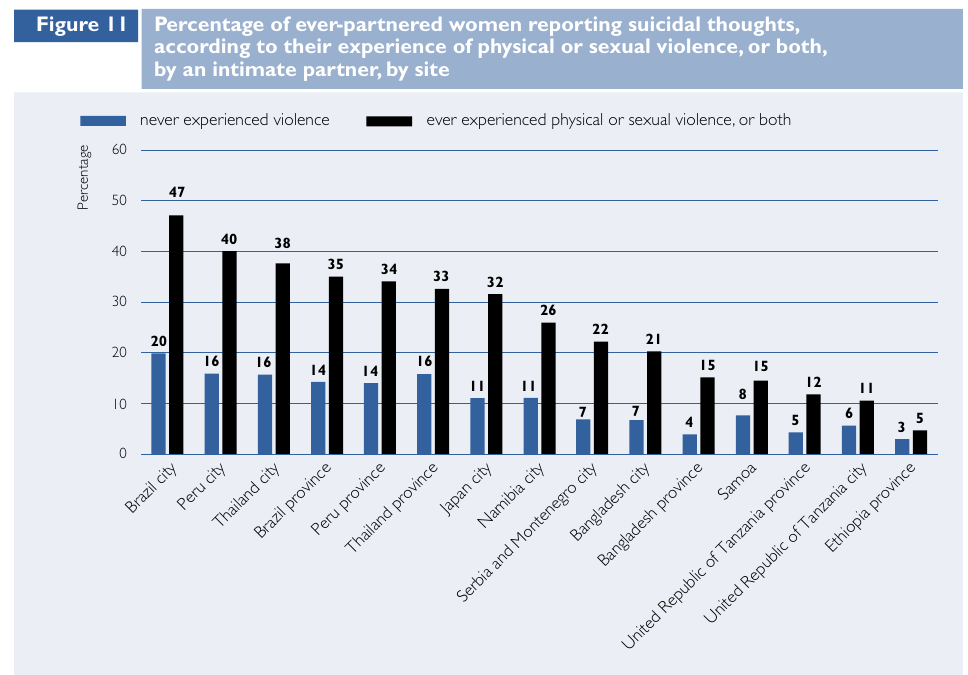
Figure 11 Percentage of ever-partnered women reporting suicidal thoughts, according to their experience of physical or sexual violence, or both, by an intimate partner, by